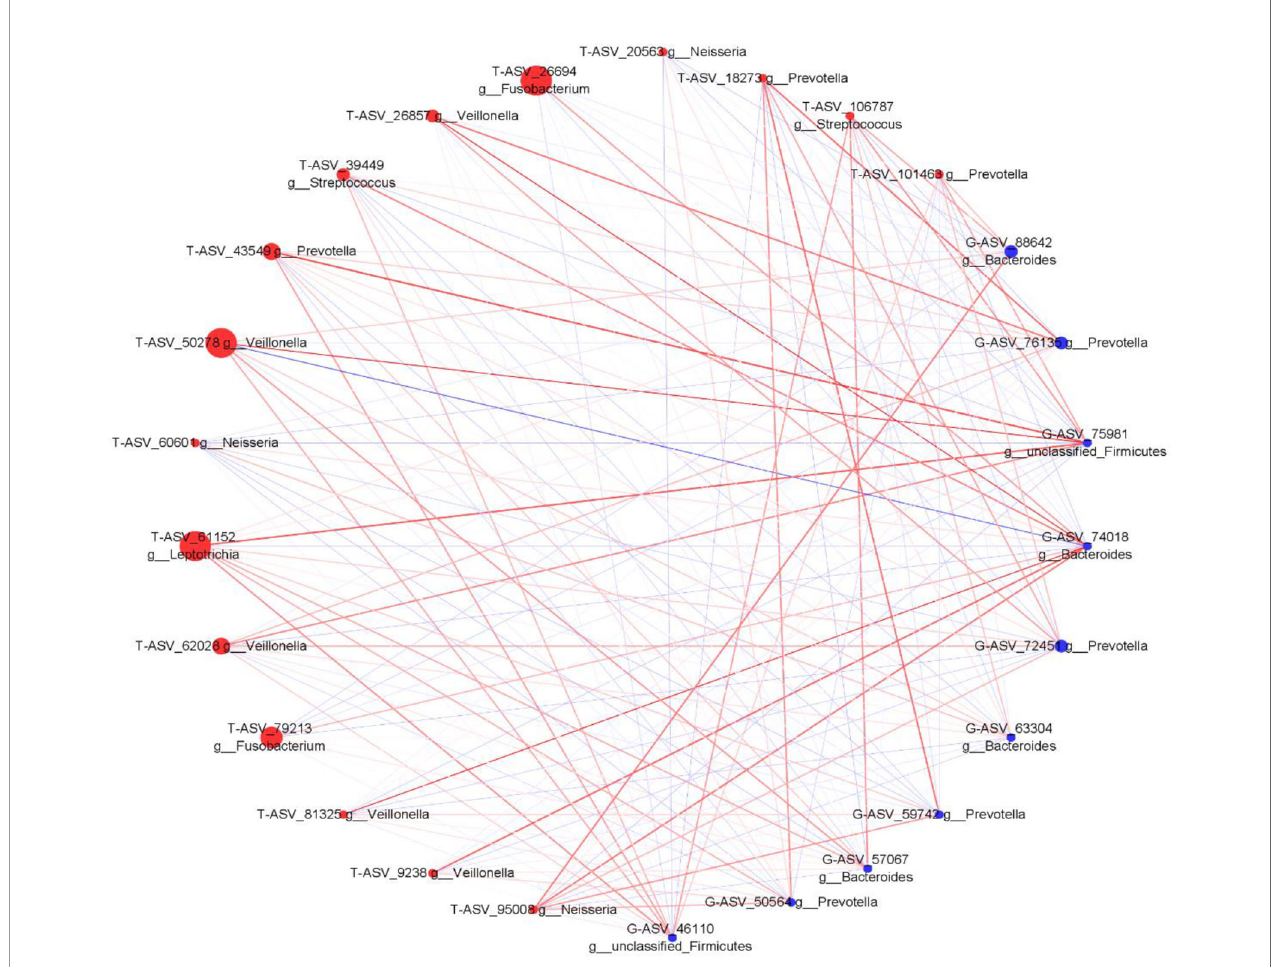
FIGURE 9 | The associated network diagrams of typical tongue coating before sleep and typical intestinal microbiota. (red is the tongue coating microbiota, blue is the intestinal microbiota, the size of the circle represents the abundance of the fl ora, the larger the area of the circle, the higher the abundance; the red line represents the positive correlation, the blue line represents the negative correlation, the thicker the line, the higher the correlation coef fi